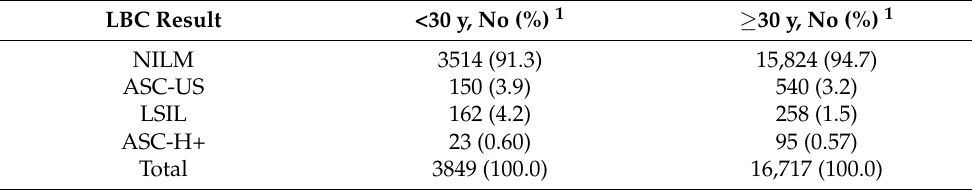
Table 1. Age-stratified LBC reporting rates (<30 and ≥ 30 years)—the baseline study